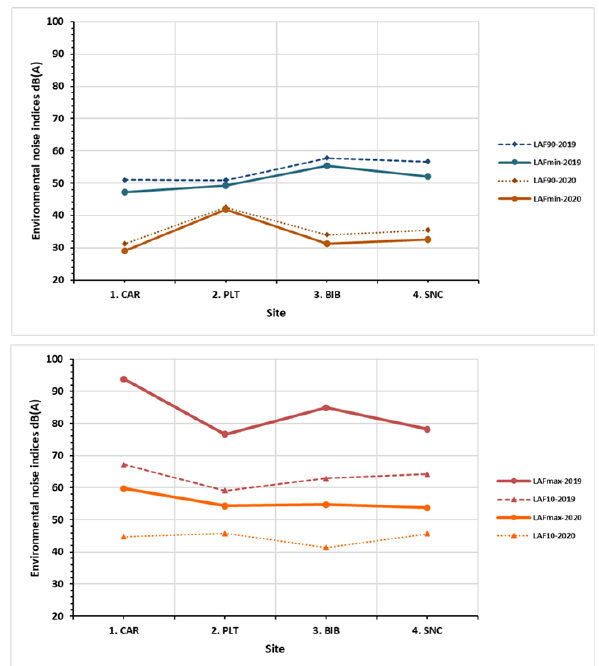
Figure 3: Environmental background and minimum noise indices (LAF90, LAFmin) (top) and environmental high and maximum noise indices (LAF10, LAFmax) comparison before (2019) and during lock- down period (2020)